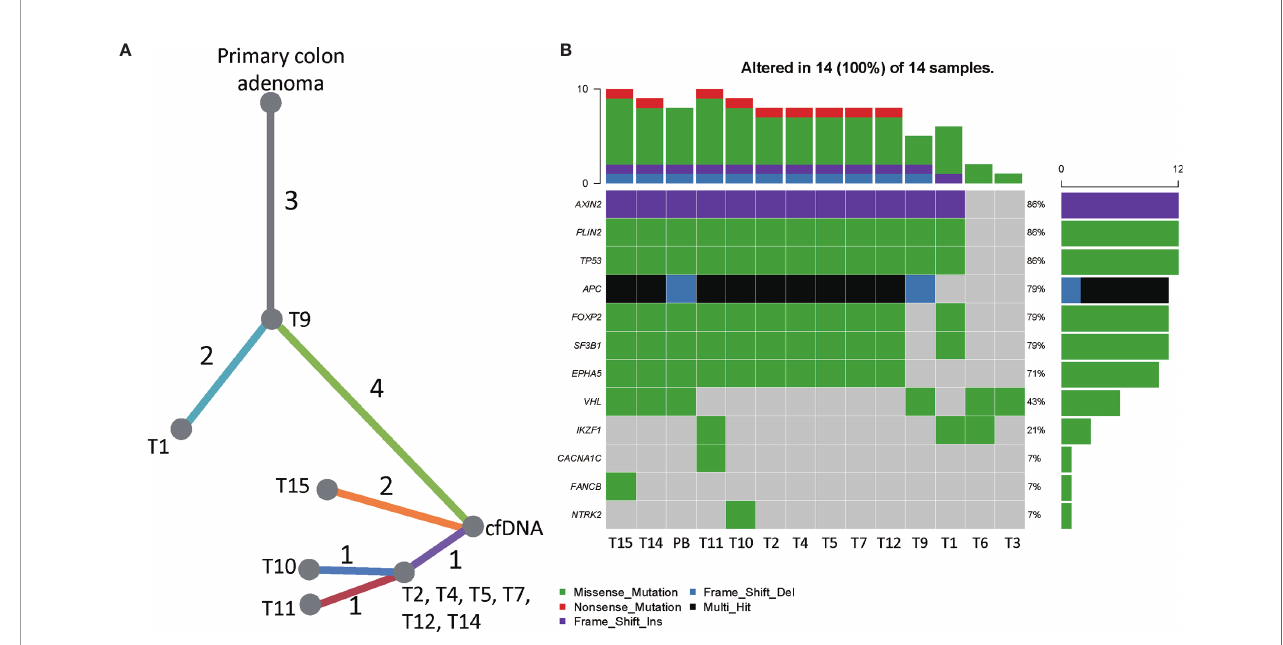
FIGURE 4 | The genetic heterogeneity of liver metastatic tumors. (A) A phylogenic tree showing the genomic similarity of the liver metastatic tumors and the primary intestinal adenoma. (B) Heatmap showing the frequencies and types of mutations of all mutated genes detected by targeted sequencing. T1-T15 were hepatic tumors and PB was the peripheral blood sample obtained in July